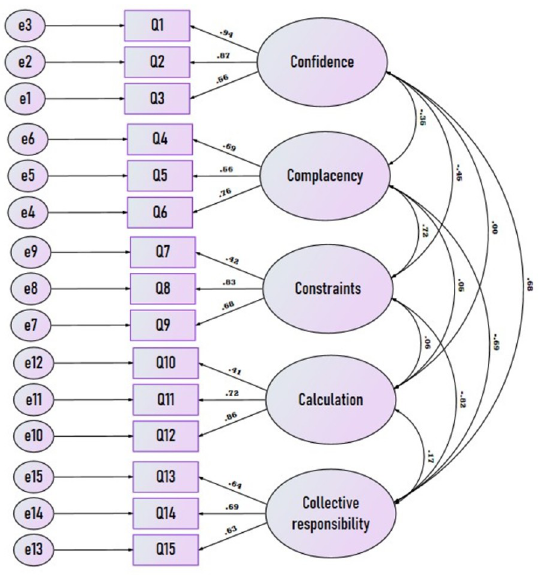
Fig 2. Confirmatory factor analysis of the 15 questions related to the 5 domains of 5C scale of vaccine antecedent.